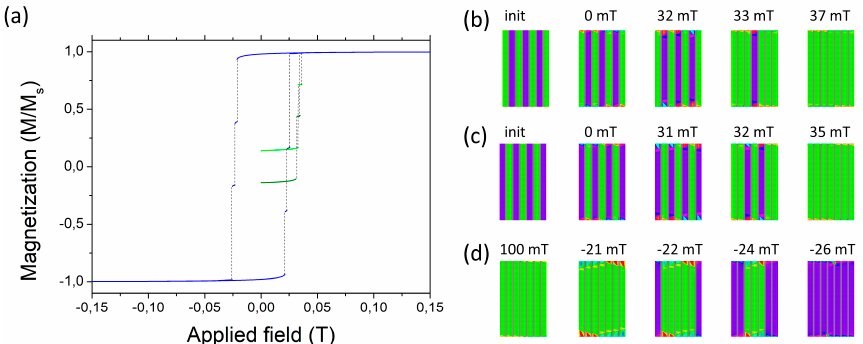
Figure 6. ( a ) Hysteresis loop for the system of seven stripes. The configuration sequence when starting from ( b ) AFu and ( c ) AFd. ( d ) the sequence in the reversal of the FM configuration.